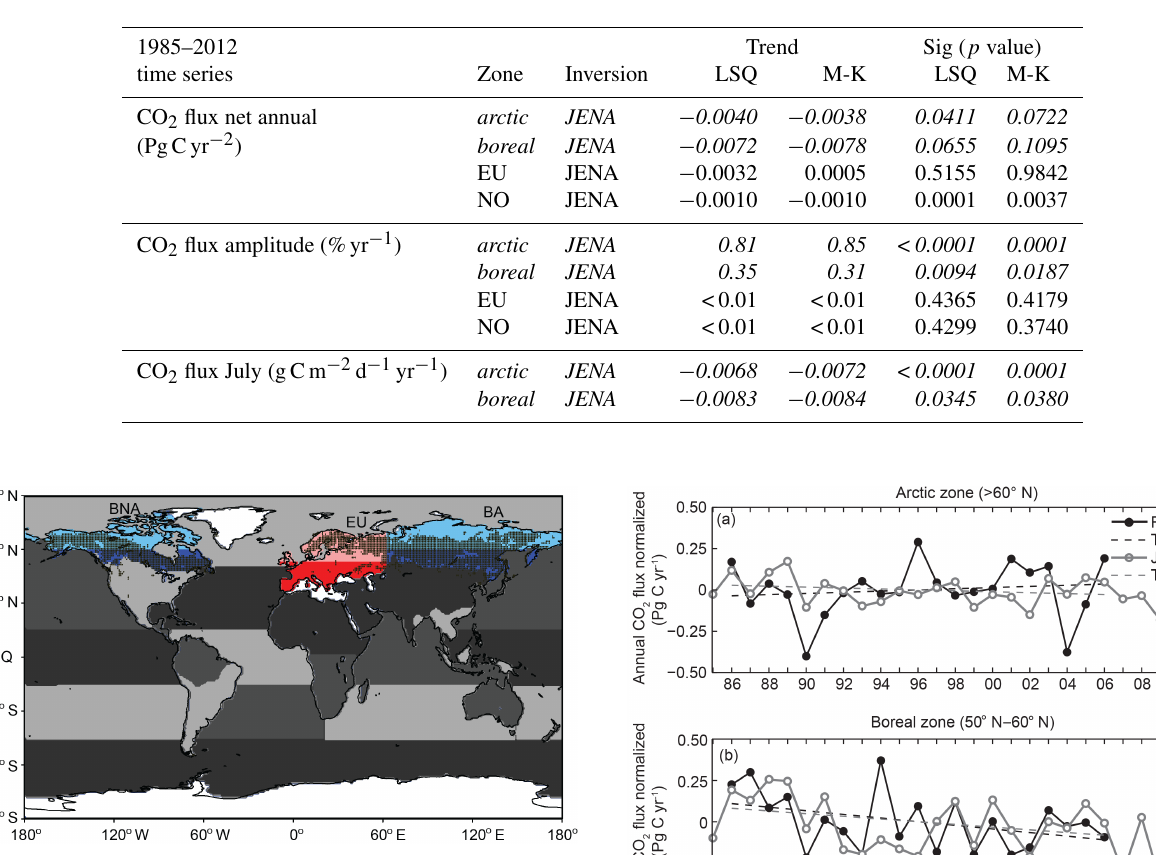
Table 3. Same as Table 2 but for the period from 1985 through 2012.